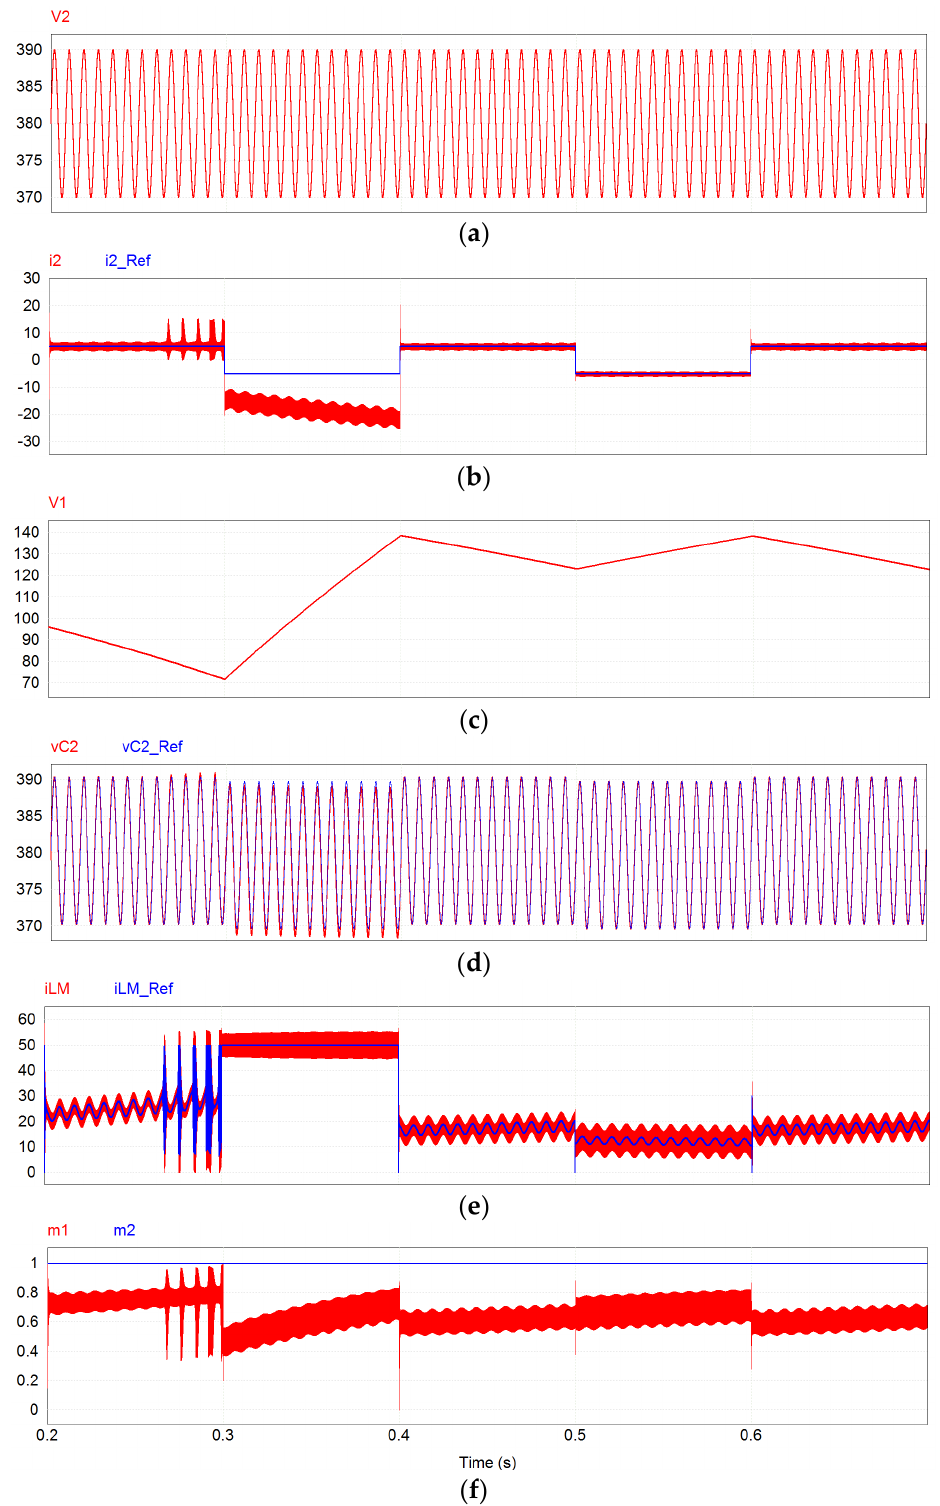
Figure 15. Waveforms for the conventional cascaded control scheme for test 2. ( a ) Voltage at Bus 2 (in V), ( b ) reference and output current (in A), ( c ) voltage at Bus 1 (in V), ( d ) reference and output capacitor voltage (in V), ( e ) reference and inductor current (in A), ( f ) PWM modulation